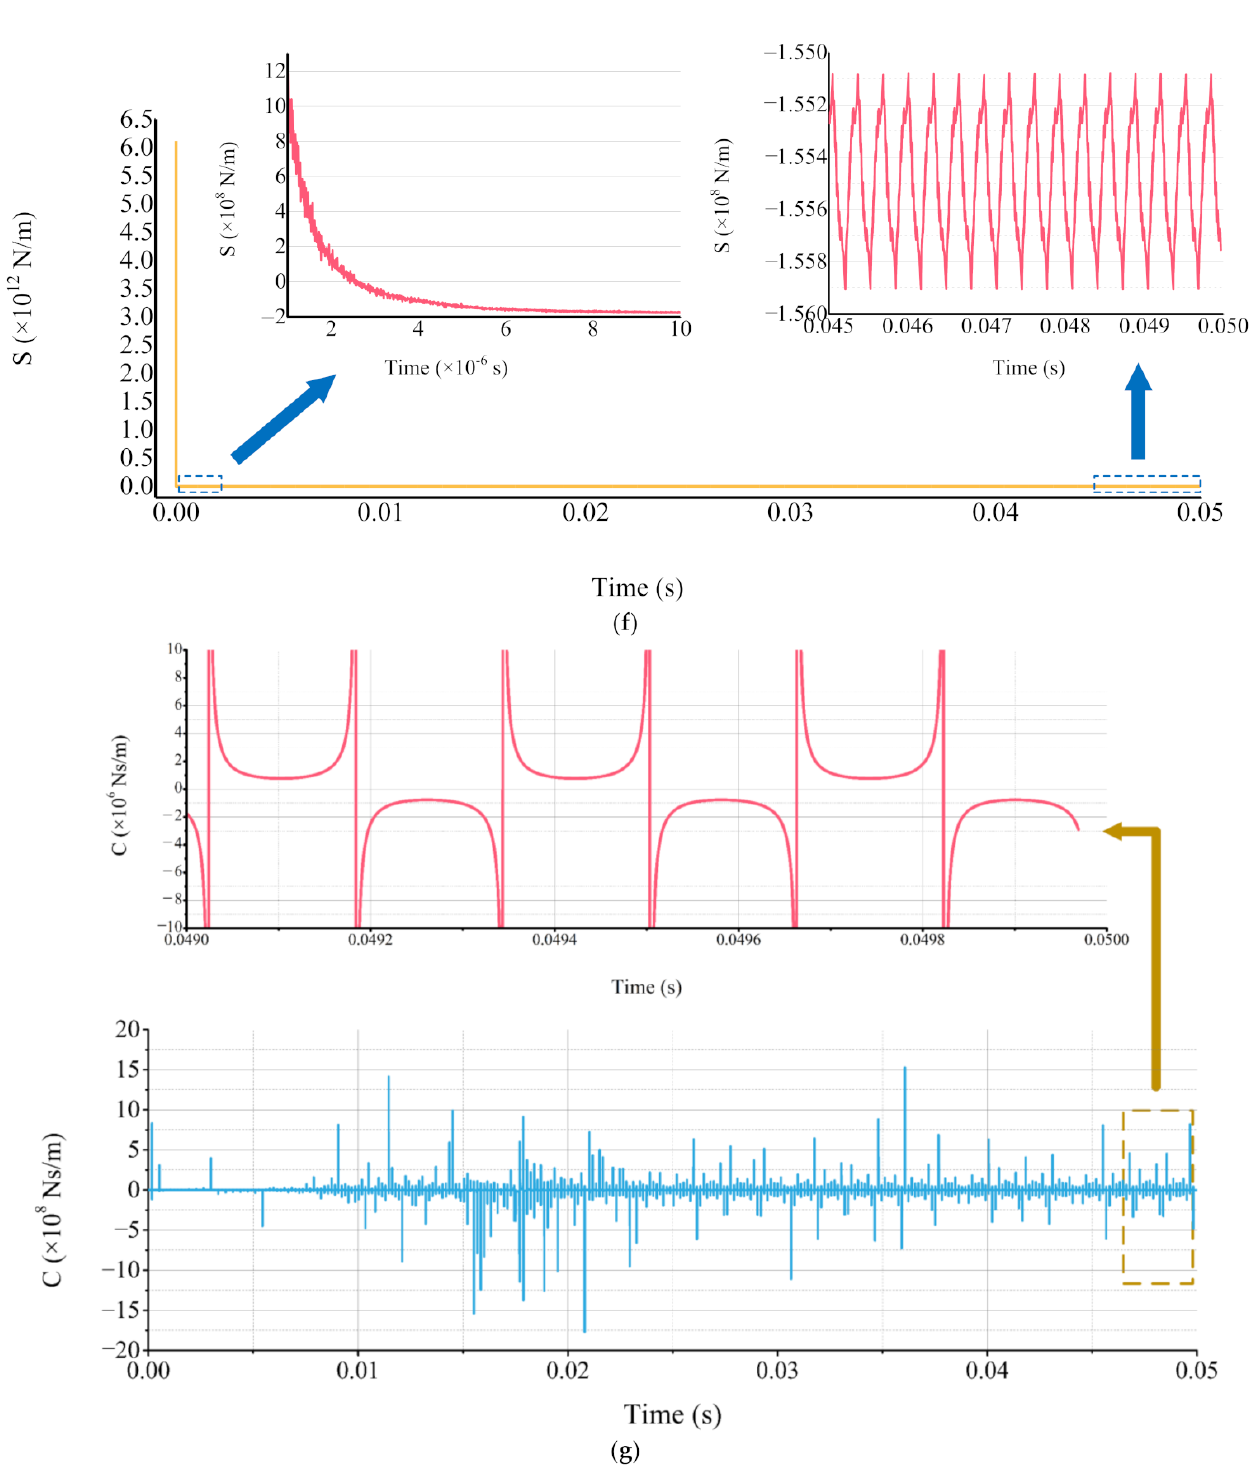
Figure 8. Variations of the dynamic parameters of the system under “5 MPa, 60 rpm, 100 N ”. ( a ) Oil film pressure. ( b ) Resultant force. ( c ) Velocity fluctuation. ( d ) ∆ z . ( e ) Inlet pressure. ( f ) S . ( g ) C